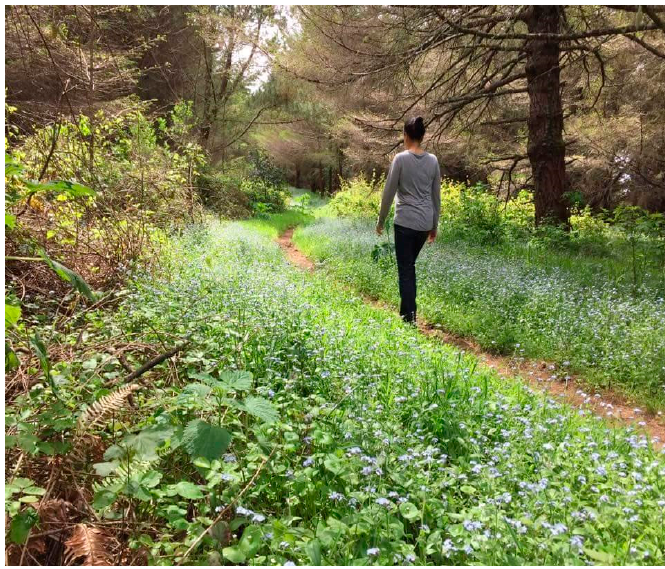
Figure 3. Walking in nature. Permission to publish from CiCi Lee.